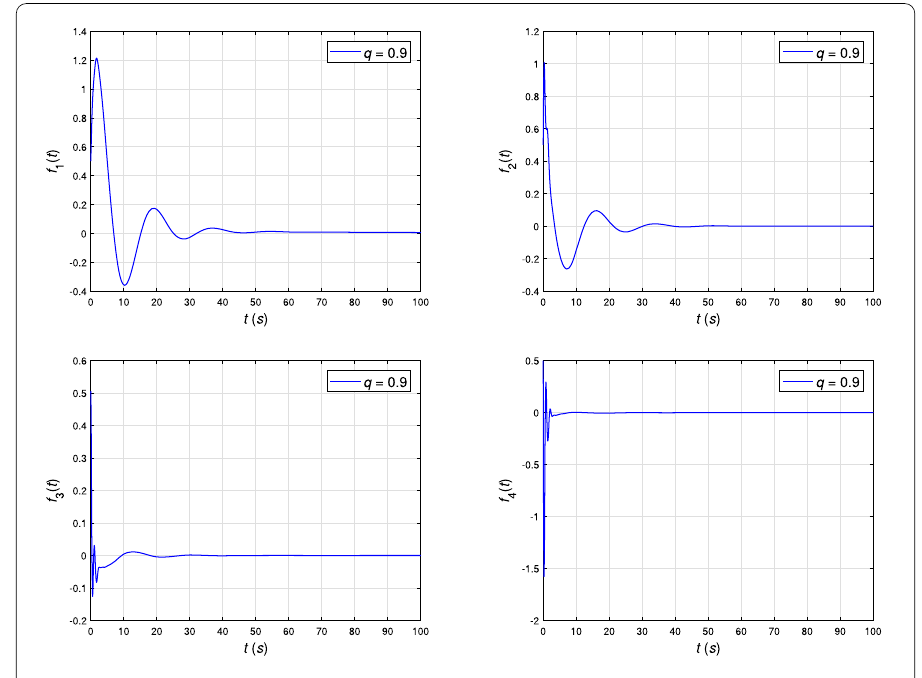
Figure 7 The time-domain responses of the controlled system (14) for q = 0.9